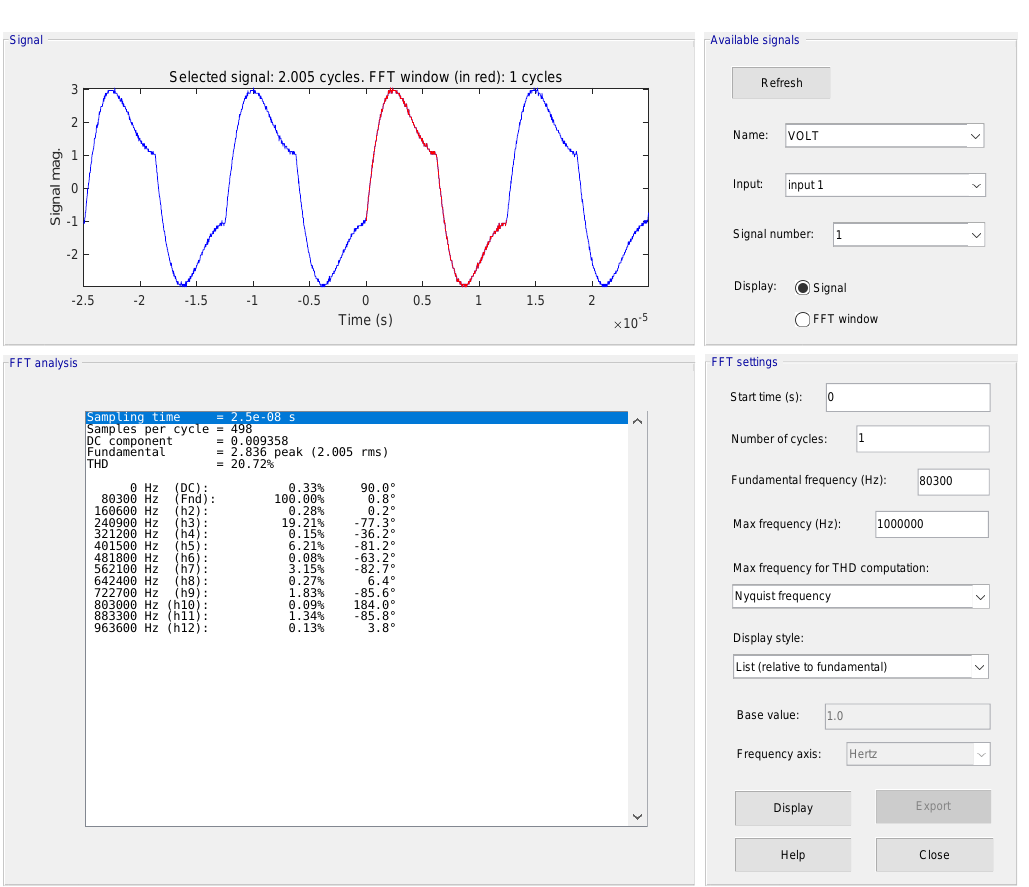
Figure 11. FFT analysis result for the output current measured in the experimental setup.